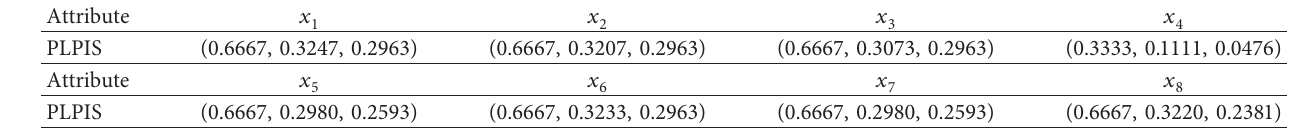
Table 8: The normalized PLPIS.